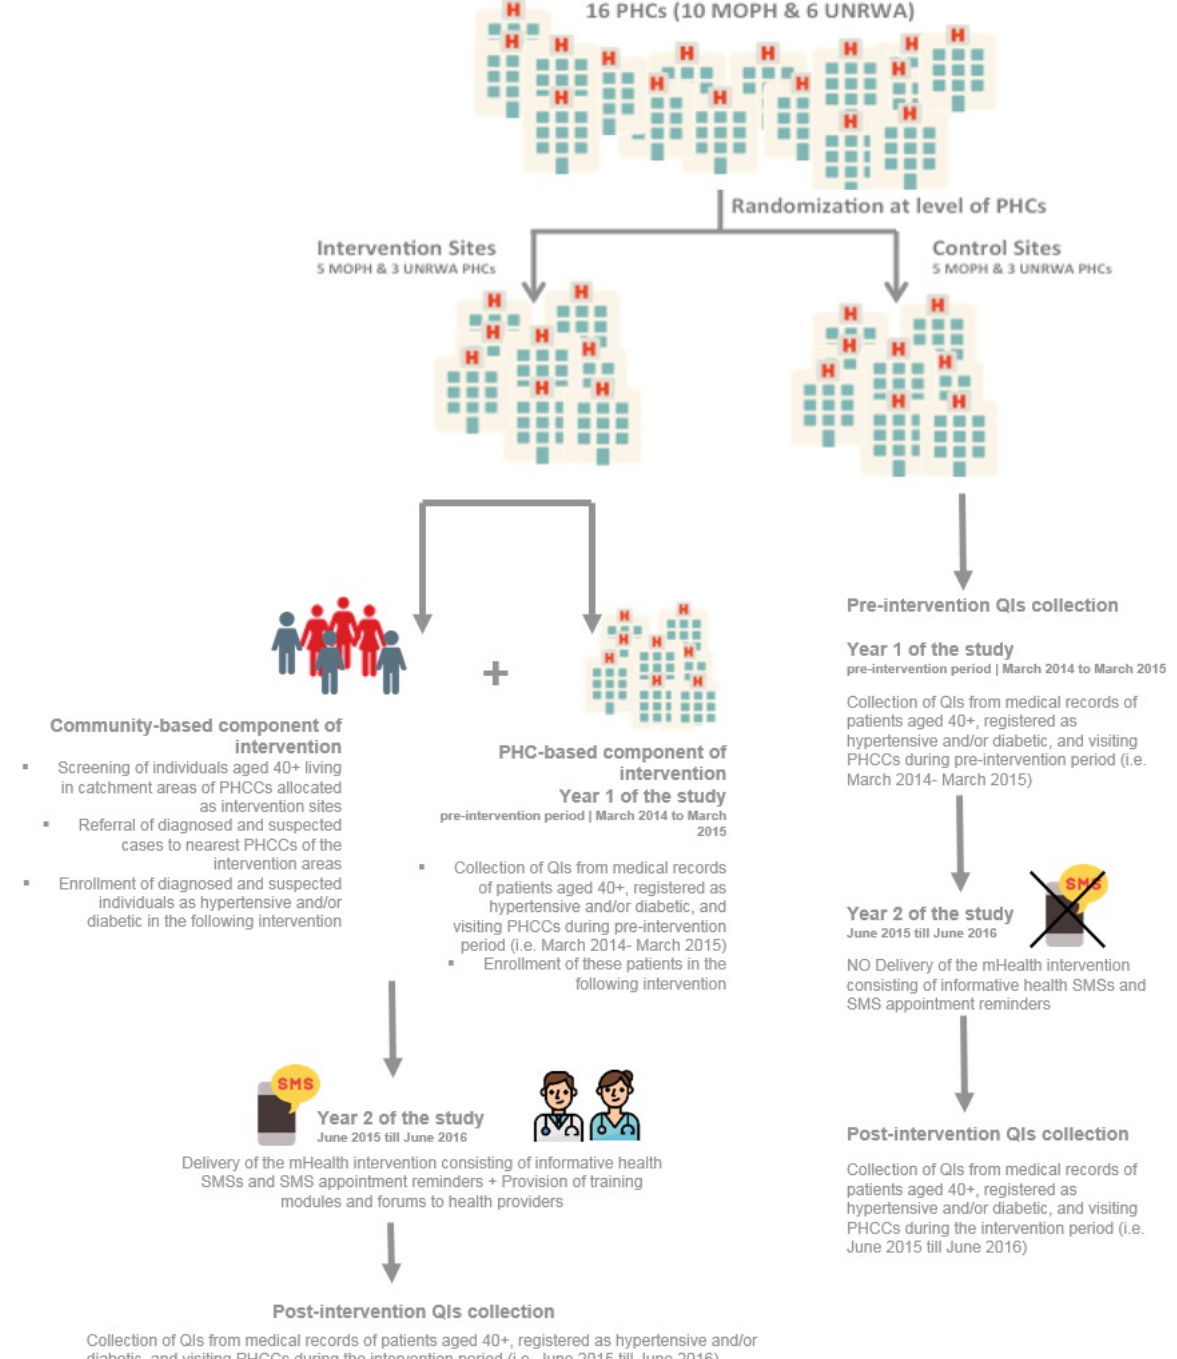
Figure 1. Summary of the methodology of the study. MOPH: Ministry of Public Health; PHC: primary health care; PHCC: primary health care